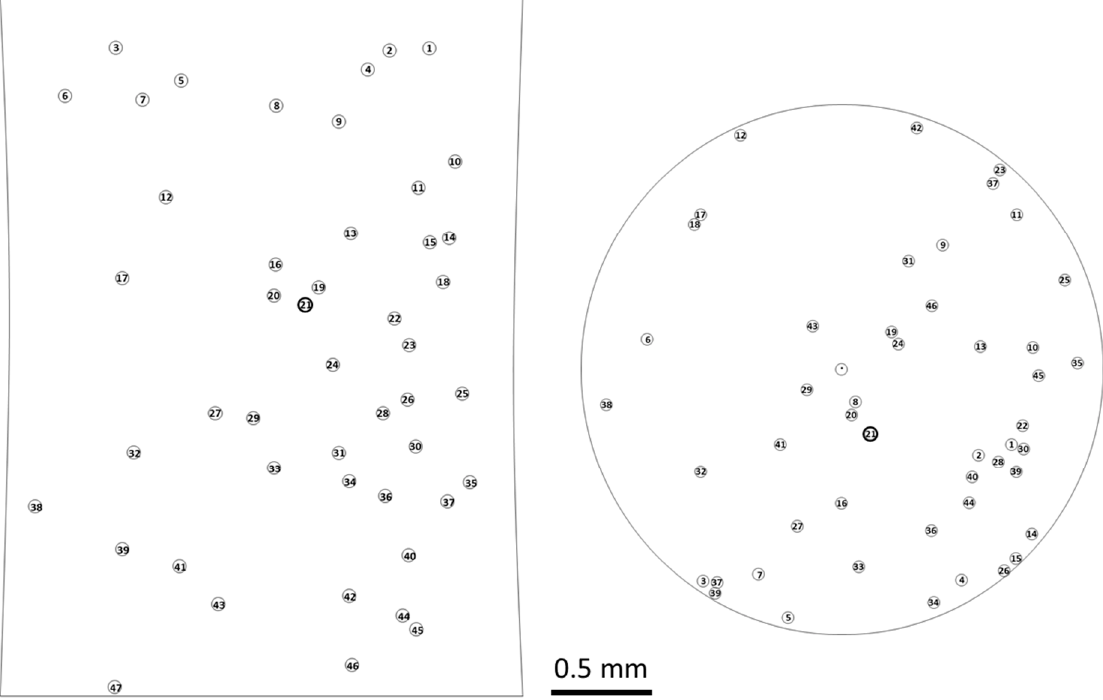
Figure 7. Locations of inclusions.